Question: State the chart type depicted above.
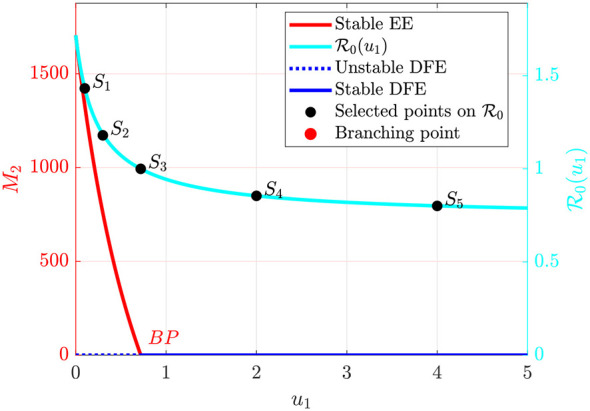
Answer: line